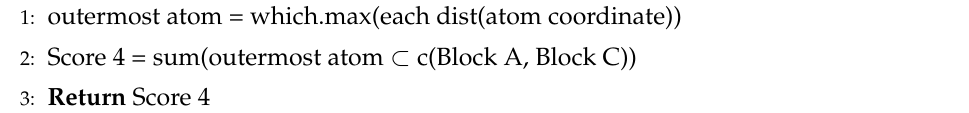
Figure 15. Number of head and tail atoms included in the hydrophilic group (Score 4). The blue dots represent the head and tail atoms, which means two atoms that have the longest distance within a molecule. Head and tail atoms can be checked to determine whether they belong to hydrophilic groups. Algorithm 5 Score 4: number of head and tail atoms included in the hydrophilic group.